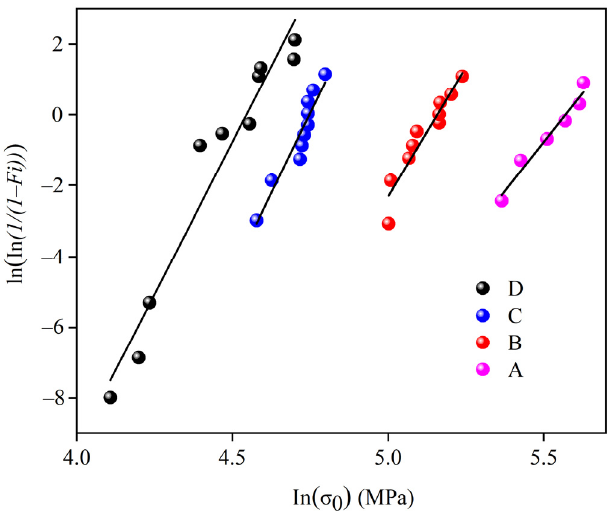
Figure 9. Weibull distribution of porous alumina prepared using different contents of the pore-